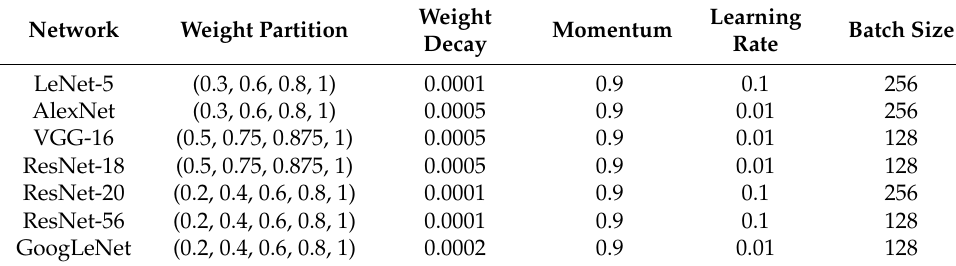
Table 3. Training parameters for different CNNs.